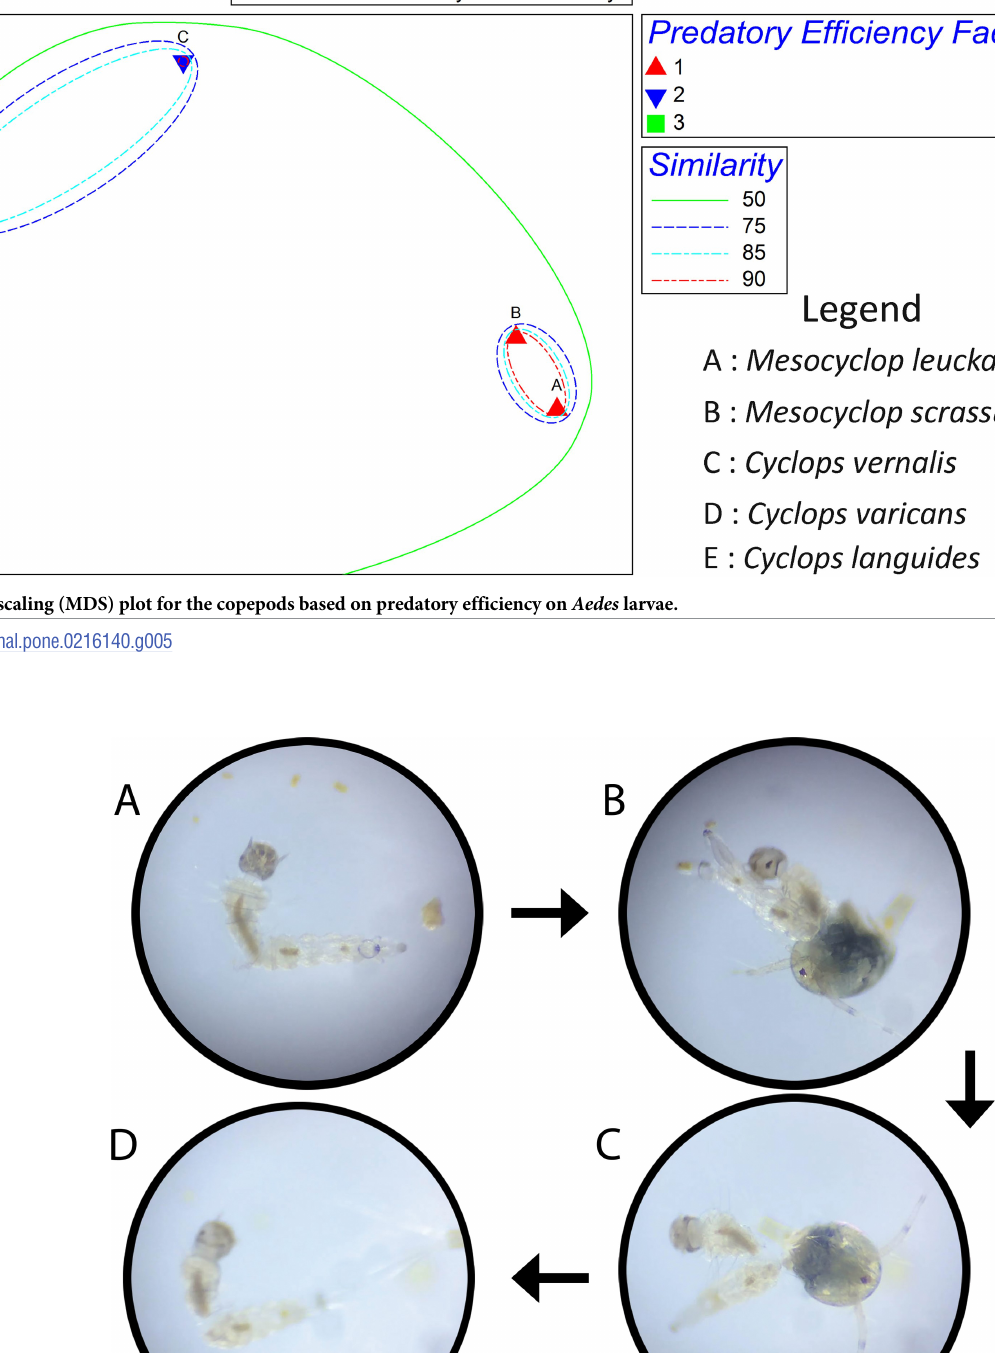
PLOS ONE | https://doi.org/10.1371/journal.pone.0216140 May 28,